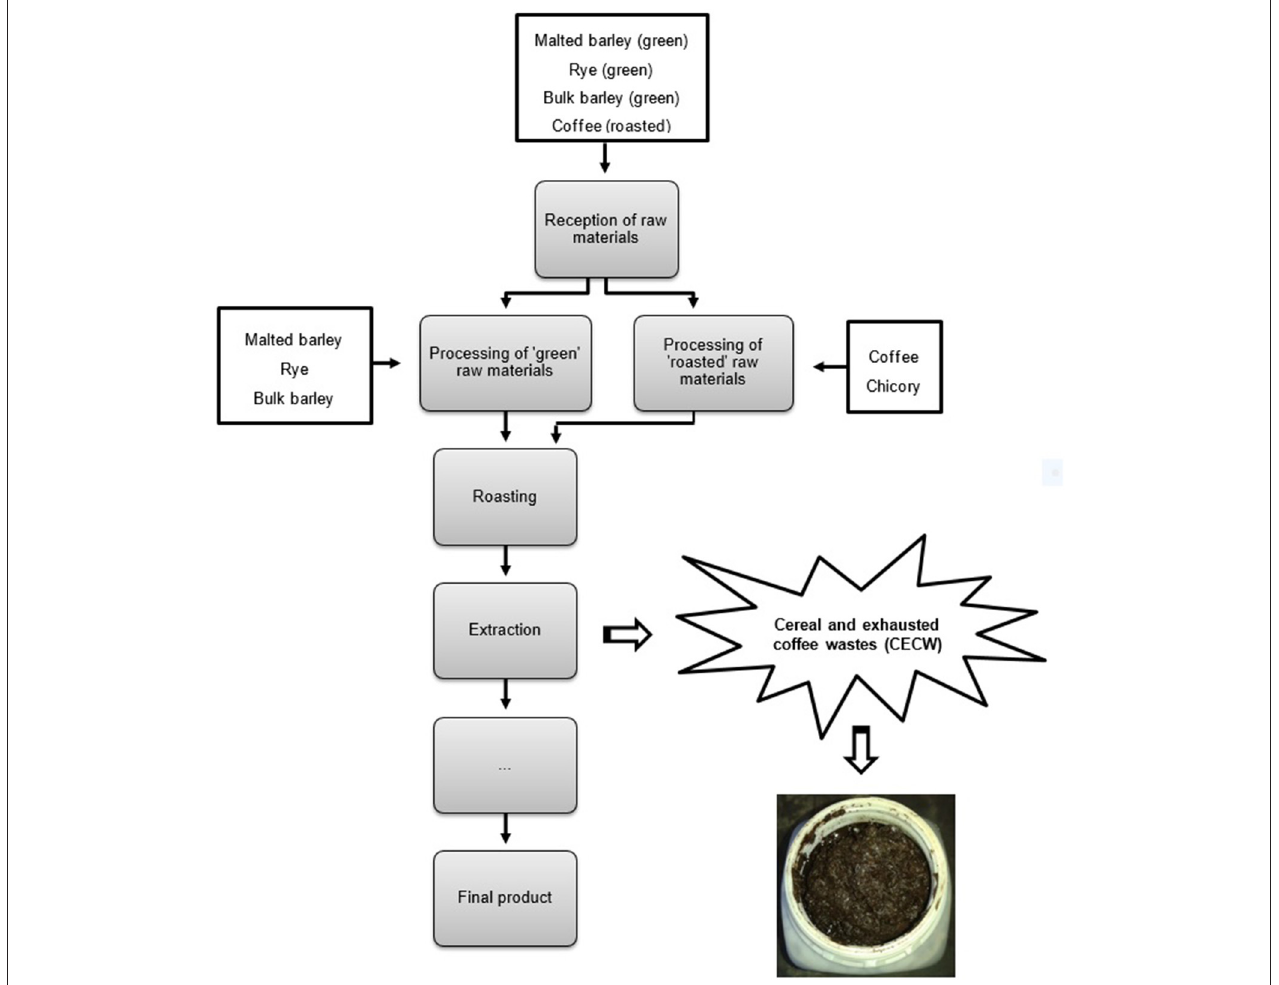
FIGURE 1 | Simplified scheme of manufacturing process of soluble coffee products.